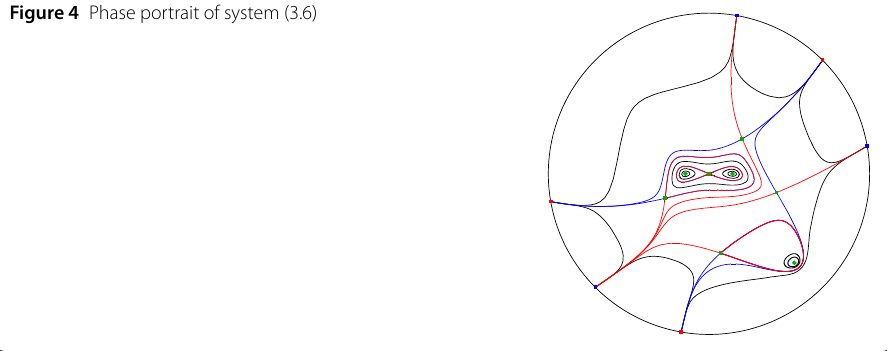
Figure 4 Phase portrait of system